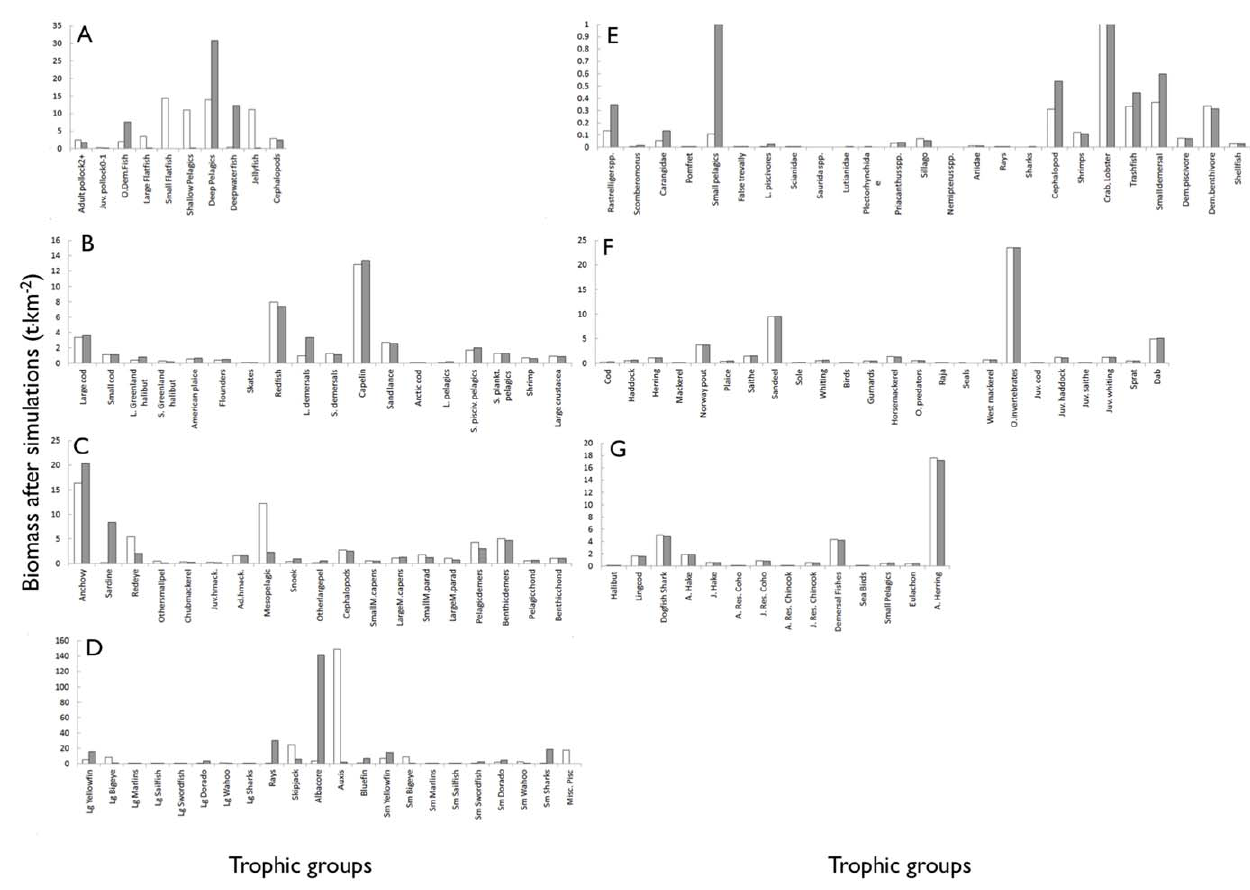
Figure 4. Biomass changes simulations with (white) and without (grey) marine mammals in the Eastern Bering Sea (A), Gulf of St. Lawrence (B), Benguela (C), Eastern tropical Pacific (D), Gulf of Thailand (E), North Sea (F), and Strait of Georgia (G) ecosystems.